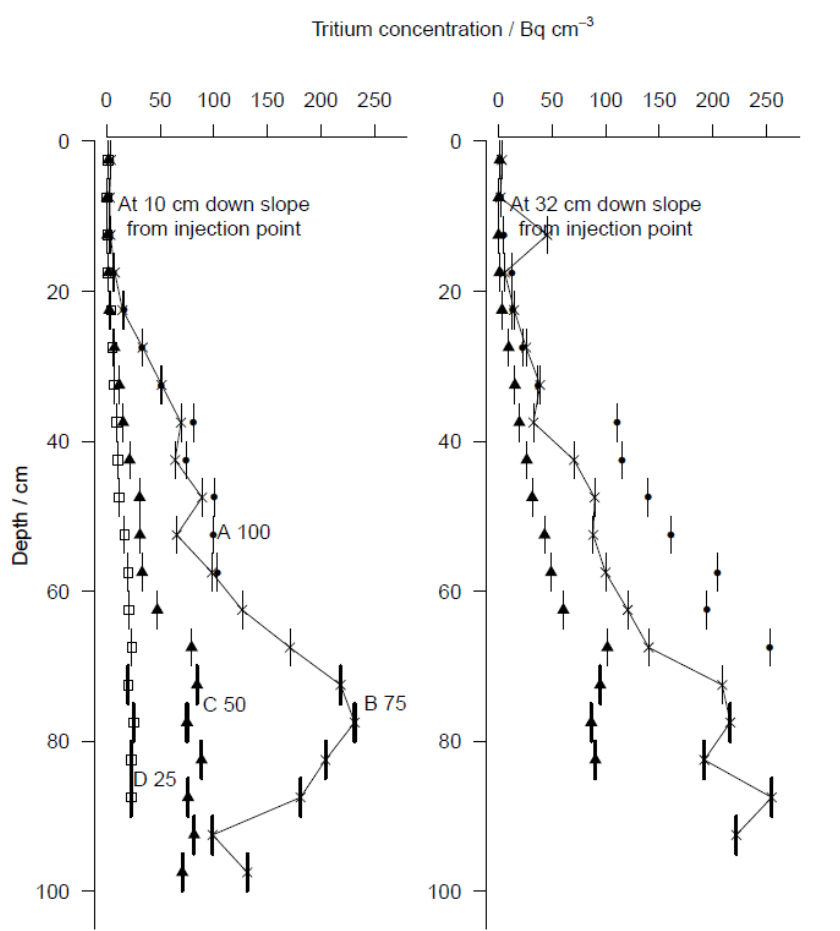
Figure 8. Profiles of concentration of tritium in pore water in 5-cm deep/long samples in cores 10 cm downslope (left) and 32 cm downslope (right) from the injection site. Results for injection sites identified by ‘A’ to ‘D’ with injection depth (cm). [In right graph, no site ‘D’.] Note, here and in later graphs, the strokes in the symbol (1 to 4) parallel the sites ‘A’ to ‘D’. Vertical bars show extent of sample - they are not error bars. Thin bars are peat, thick bars are clay. In both graphs the site ‘B’ samples are linked by